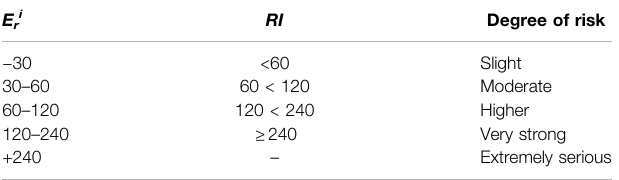
TABLE 2 | Criteria for evaluating the degree of ecological risk.